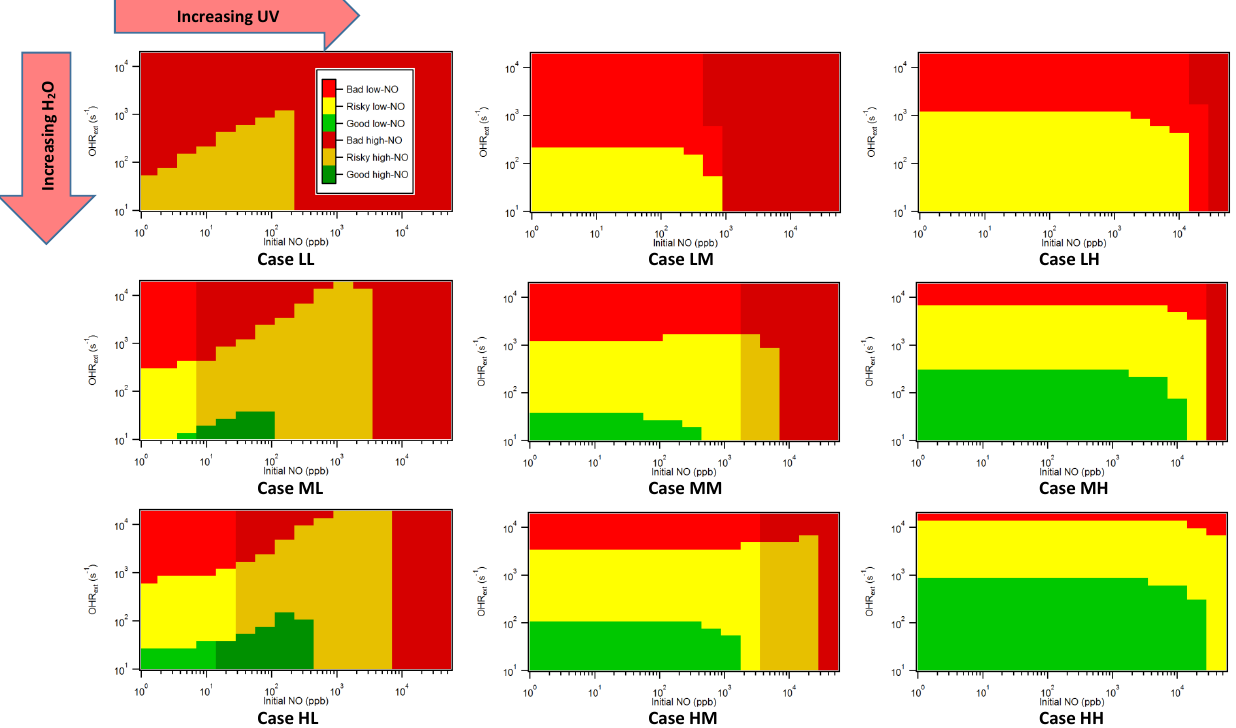
Figure 4. Image plots of the condition types defined in Table 3 vs. external OH reactivity (excluding N-containing species) and initial NO for several typical cases in OFR185-iNO (see Table 2 for the case label